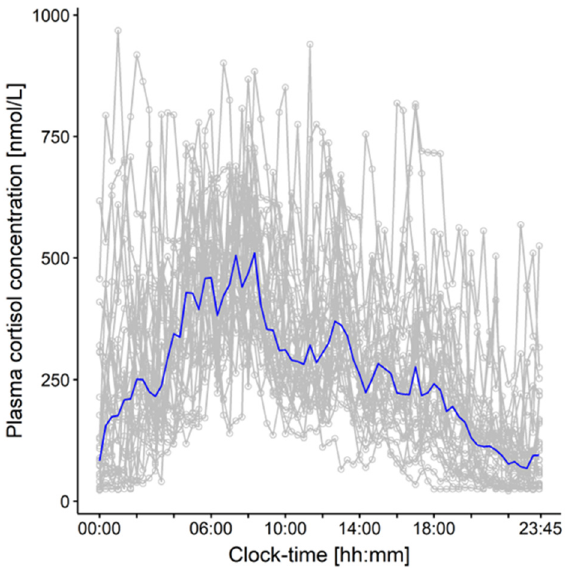
Figure 2. Individual plasma cortisol concentration-time profiles (gray) and median plasma cortisol concentration-time profiles (blue) obtained over 24 h from 28 healthy children aged 5–9 years.